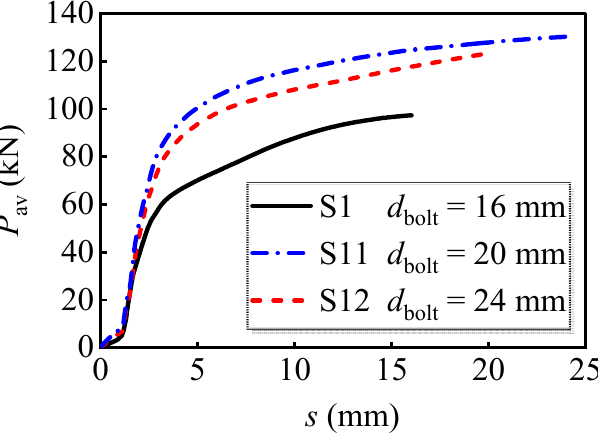
Figure 14. Average load versus slip curves of models with different bolt diameters.